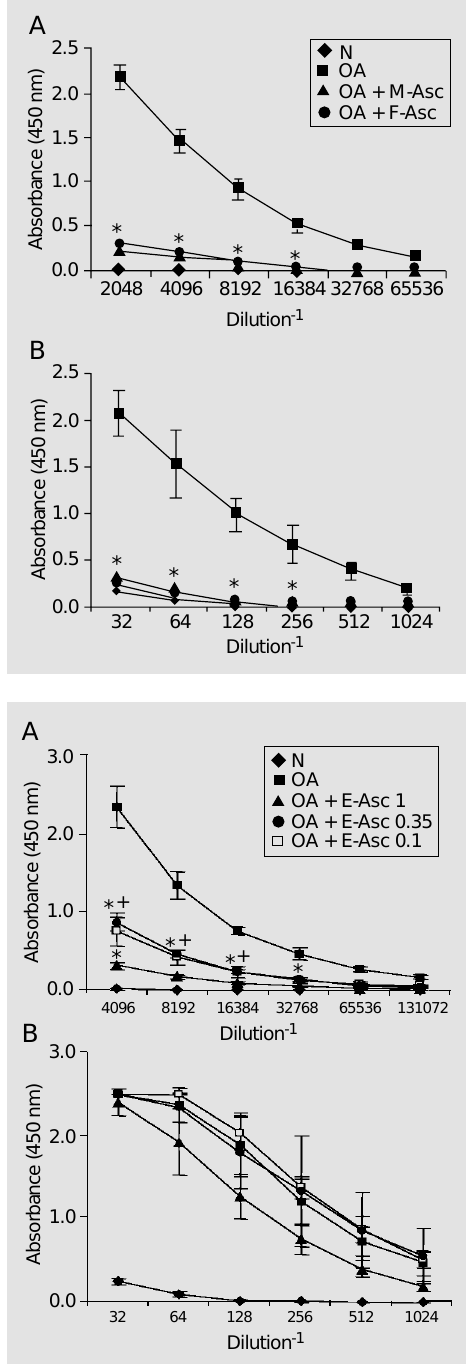
Figure 3. Ovalbumin (OA)-specif- ic IgG1 (A) and IgG2a (B) anti- bodies produced by OA or OA + Ascaris suum egg (E-Asc) ex- tract-immunized mice (1, 0.35 and 0.1 mg). Isotype levels were titrated by ELISA in normal (N) or immune plasma obtained after 9 days of immunization using monospecific antisera. The re- sults represent the mean ± SEM absorbance for 5-7 animals. *P<0.05 compared with the OA- immunized group. + P<0.05 com- pared with the OA + E-Asc (1 mg)-immunized group (Tukey